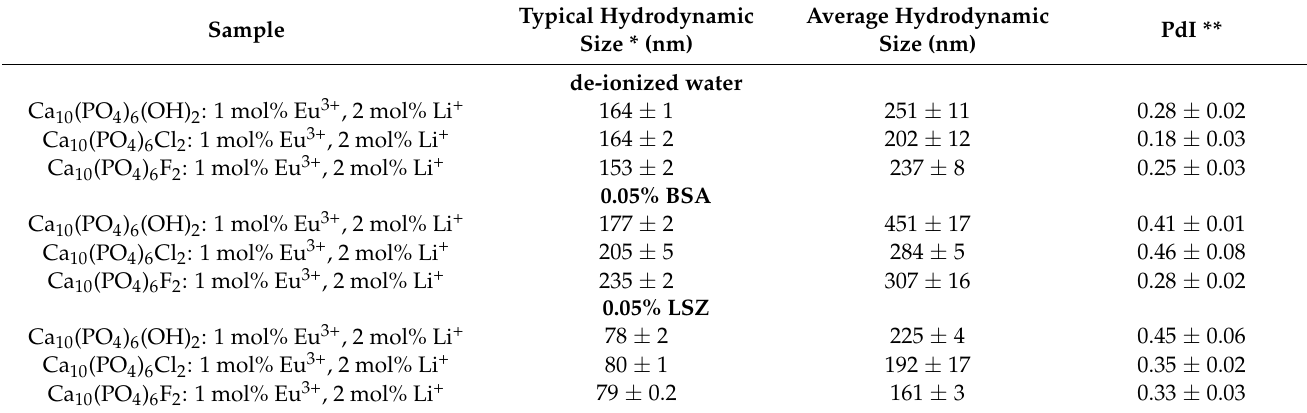
Figure 5. Hydrodynamic size distribution of the nanoapatites water colloidal suspensions: Ca 10 (PO 4 ) 6 (OH) 2 ( a ), Ca 10 (PO 4 ) 6 Cl 2 ( b ) and Ca 10 (PO 4 ) 6 F 2 ( c ) co-doped with 1 mol% Eu 3+ and 2 mol% Li + ions. Presented values are the mean ± SD of three independent experiments. Table 3. Main hydrodynamic size of nanoapatites colloidal suspensions: Ca 10 (PO 4 ) 6 (OH) 2 , Ca 10 (PO 4 ) 6 Cl 2 and Ca 10 (PO 4 ) 6 F 2 co-doped with 1 mol% Eu 3+ and 2 mol% Li + ions, measured in de-ionized water, 0.05% BSA and 0.05% LSZ based on DLS